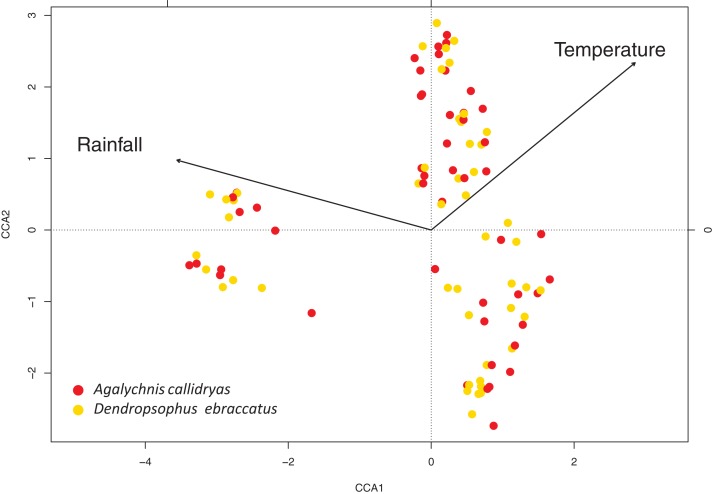
Canonical correspondence analysis of the variation in bacterial community structure on the skin of both treefrog species.Canonical (constrained) correspondence analysis shows that environmental variables (rainfall and temperature) are associated with temporal variation in community structure of skin-associated bacteria on Agalychnis callidryas (red) and Dendropsophus ebraccatus (yellow).